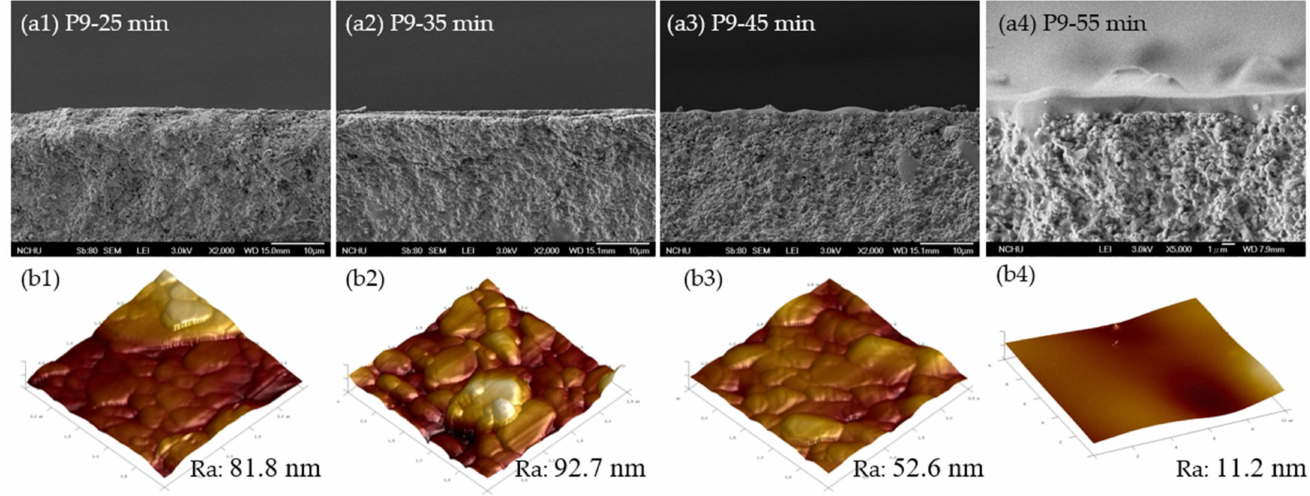
Figure 3. Scanning electron microscopy (SEM) ( a ) and atomic force microscopy (AFM) ( b ) images of the P9 membrane